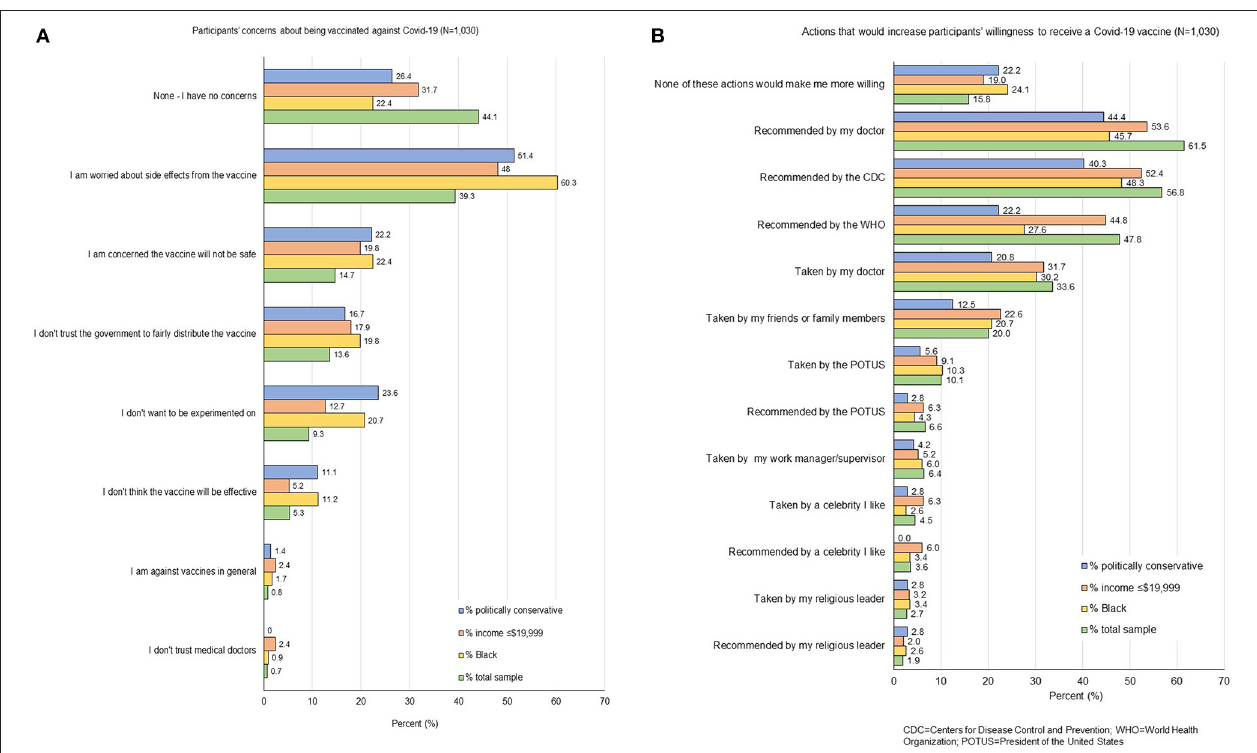
FIGURE 1 | (A) Participants’ concerns about being vaccinated against COVID-19 ( N = 1,030). (B) Actions that would increase participants’ willingness to receive a COVID-19 vaccine ( N = 1,030).